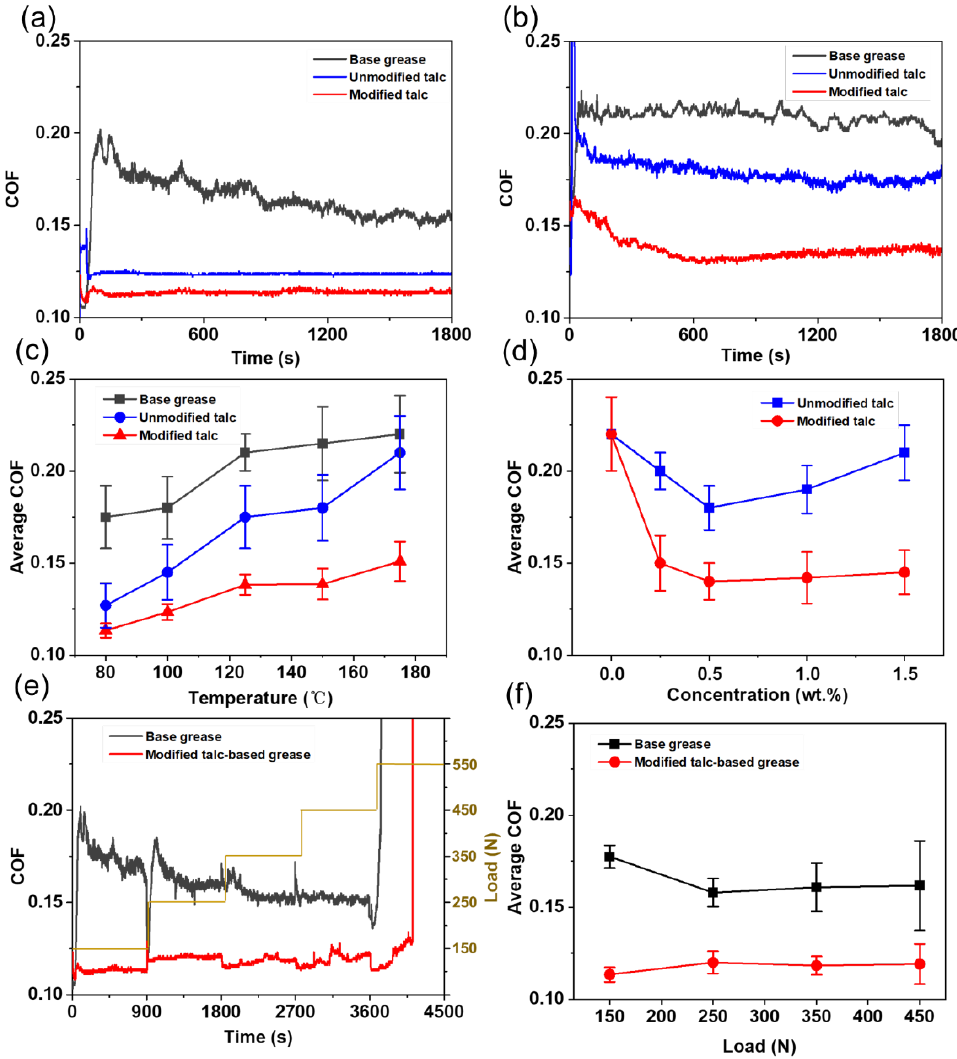
Figure 6. COFs of talc-based grease compared with base grease at the temperature of 80 °C ( a ) and 150°C ( b ); the COFs at different temperature (0.5 wt.%) ( c ) and at different concentration (150 °C) ( d ) under the load of 150 N; the effect of load on the lubrication ( e , f ) at the temperature of 80 °C.